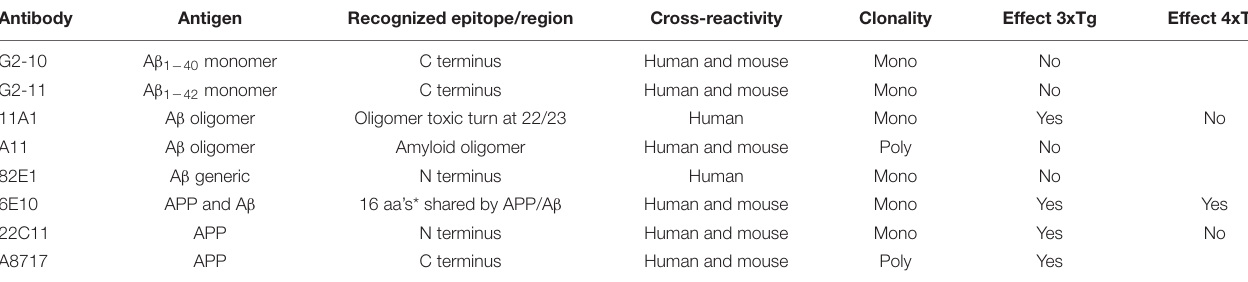
TABLE 1 | Antibodies used to block APP and A β